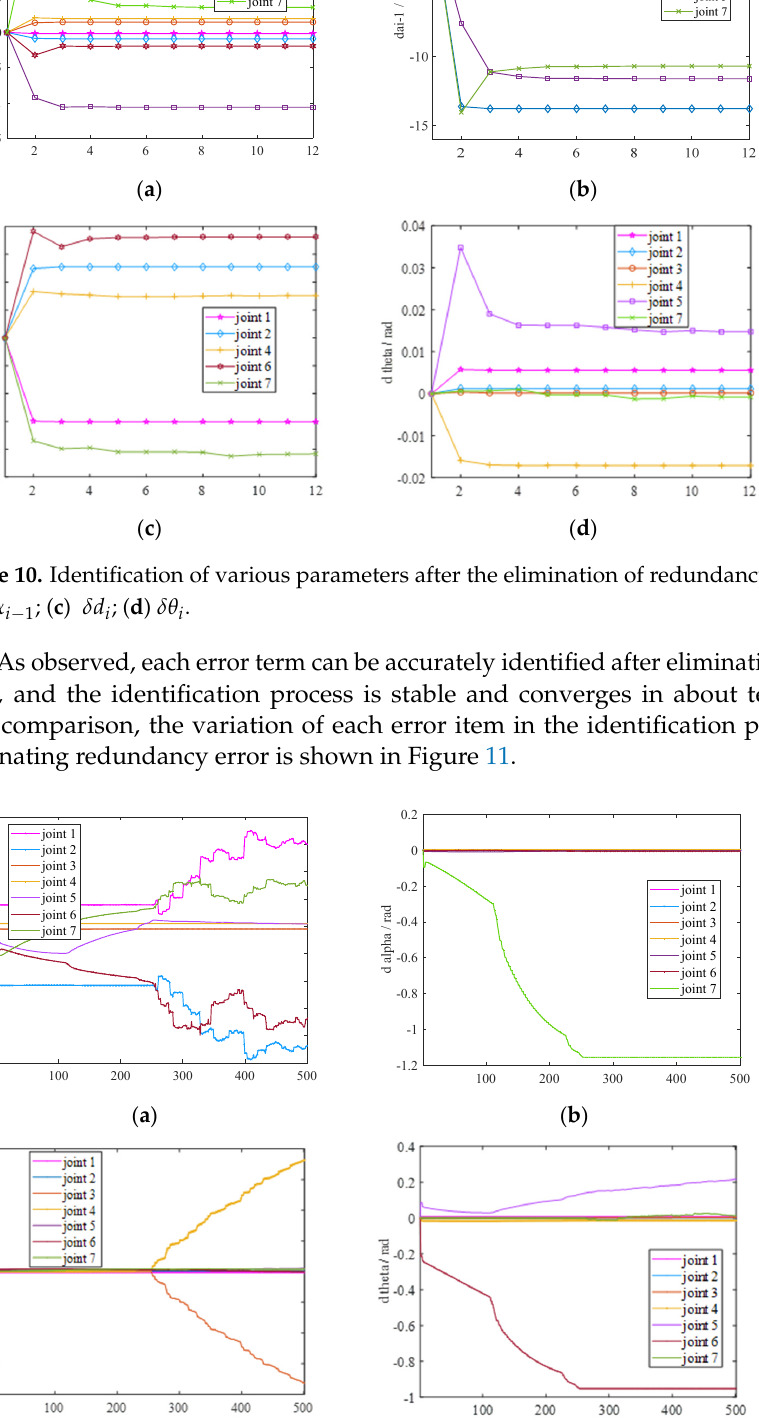
( b ) ( c ) Figure 12. Comparison of kinematic calibration and non-calibration in the X- ( a ) Y- ( b ) and Z- ( c ) directions. To illustrate the correctness of the gravity compensation model and the kinematic calibration method considering gravitational deformation, the errors in the X-, Y-, and Z- directions of the measurement points obtained by using the method considering only E x / m E y / m